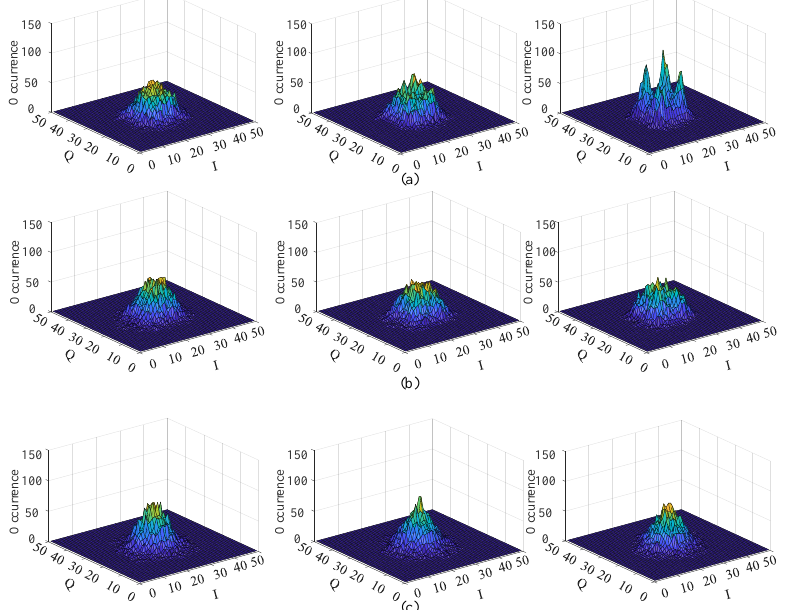
Figure 4. IQH-based features for QPSK signal at different OSNR values (i.e., left (12 dB), middle (18 dB), and (24 dB)) at: ( a ) CD = 80 ps/nm and interference ratio = 1.1; ( b ) CD = 400 ps/nm and interference ratio = 1.7; and ( c ) CD = 800 ps/nm and interference ratio =